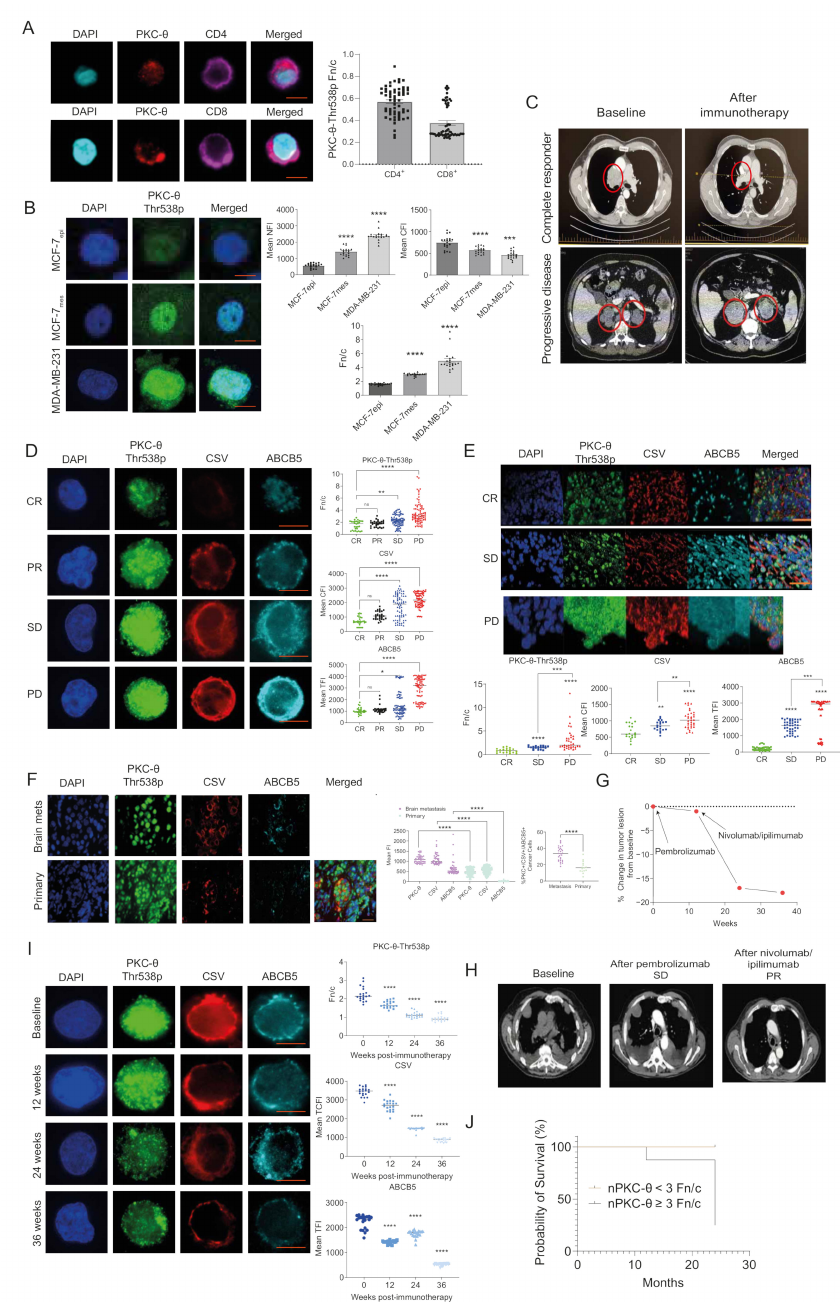
Figure 1. nPKC- θ signatures are enriched in CTCs and metastatic tissues and are associated with poor patient survival in immunotherapy-resistant disease. ( A ) Immunohistofluorescence analysis of PKC- θ expression in CD4 + and CD8 + T cells isolated from healthy donor liquid biopsies. Bar/dot plots show the Fn/c (nuclear to cytoplasmic ratio) of PKC- θ phosphorylated at threonine 568 (PKC- θ -Thr568p). A score below 1 indicates cytoplasmic bias. Data are from three separate patients, n ≥ 20 cells per patient. Representative images are shown for each dataset. PKC- θ -Thr568p (red); CD8/CD4 (purple), and DAPI (cyan) were used to visualize expression and nuclei; scale bar represents 10 µ M. ( B ) Immuno- histofluorescence analysis of PKC- θ expression in human MCF-7 inducible model (MCF-7-IM) and MDA-MB-231 breast cancer cells. Human MCF-7 epithelial cells (MCF-7epi) were activated with PMA to induce EMT and generate MCF-7 mesenchymal-like (MCF-7mes) breast cancer cells. Bar graphs show the mean nuclear fluorescence intensity (NFI), cytoplasmic fluorescence intensity (CFI), and Fn/c for PKC- θ -Thr568p, n ≥ 20 cells per group. Representative images are shown for each dataset. PKC- θ -Thr568p (green) and DAPI (blue) were used to visualize nuclei. Scale bar represents 10 µ M. ( C